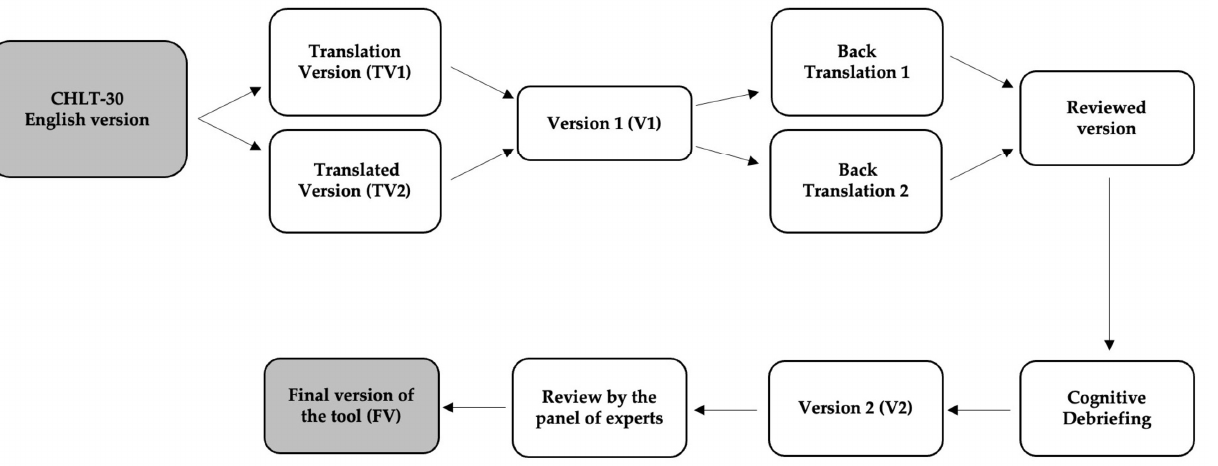
Figure 1. Process of translation and cultural adaptation of the English version of the Cancer Health Literacy Test (CHLT ‐ 30) [29] into Portuguese language.